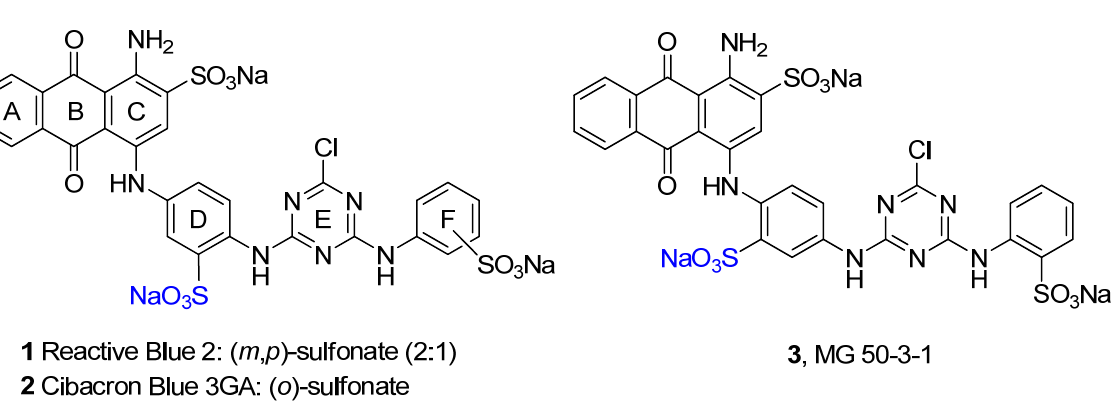
Figure 1. Structures of Reactive Blue 2 (RB-2, 1 ), Cibacron Blue 3GA ( 2 ) and MG 50-3-1 ( 3